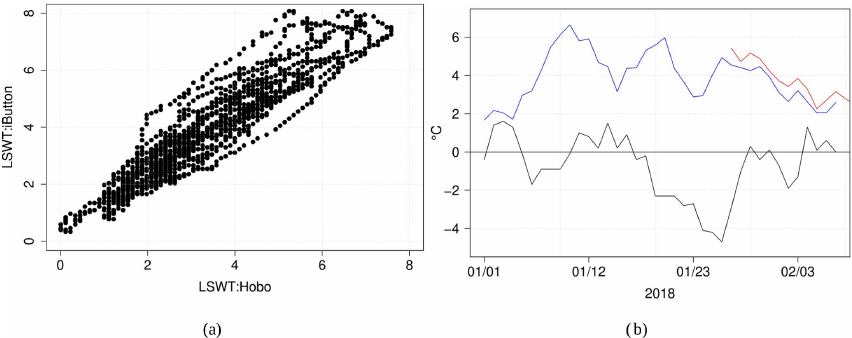
Figure 4. (a) The 10min lake surface water temperature (LSWT) measured by the HOBO temperature sensor ( x axis) and iButton sensor ( y axis); (b) daily time series of the lake surface water temperature measured by the HOBO (blue) and by the iButton (red) and the air temperature measured at the Maitri site (black).